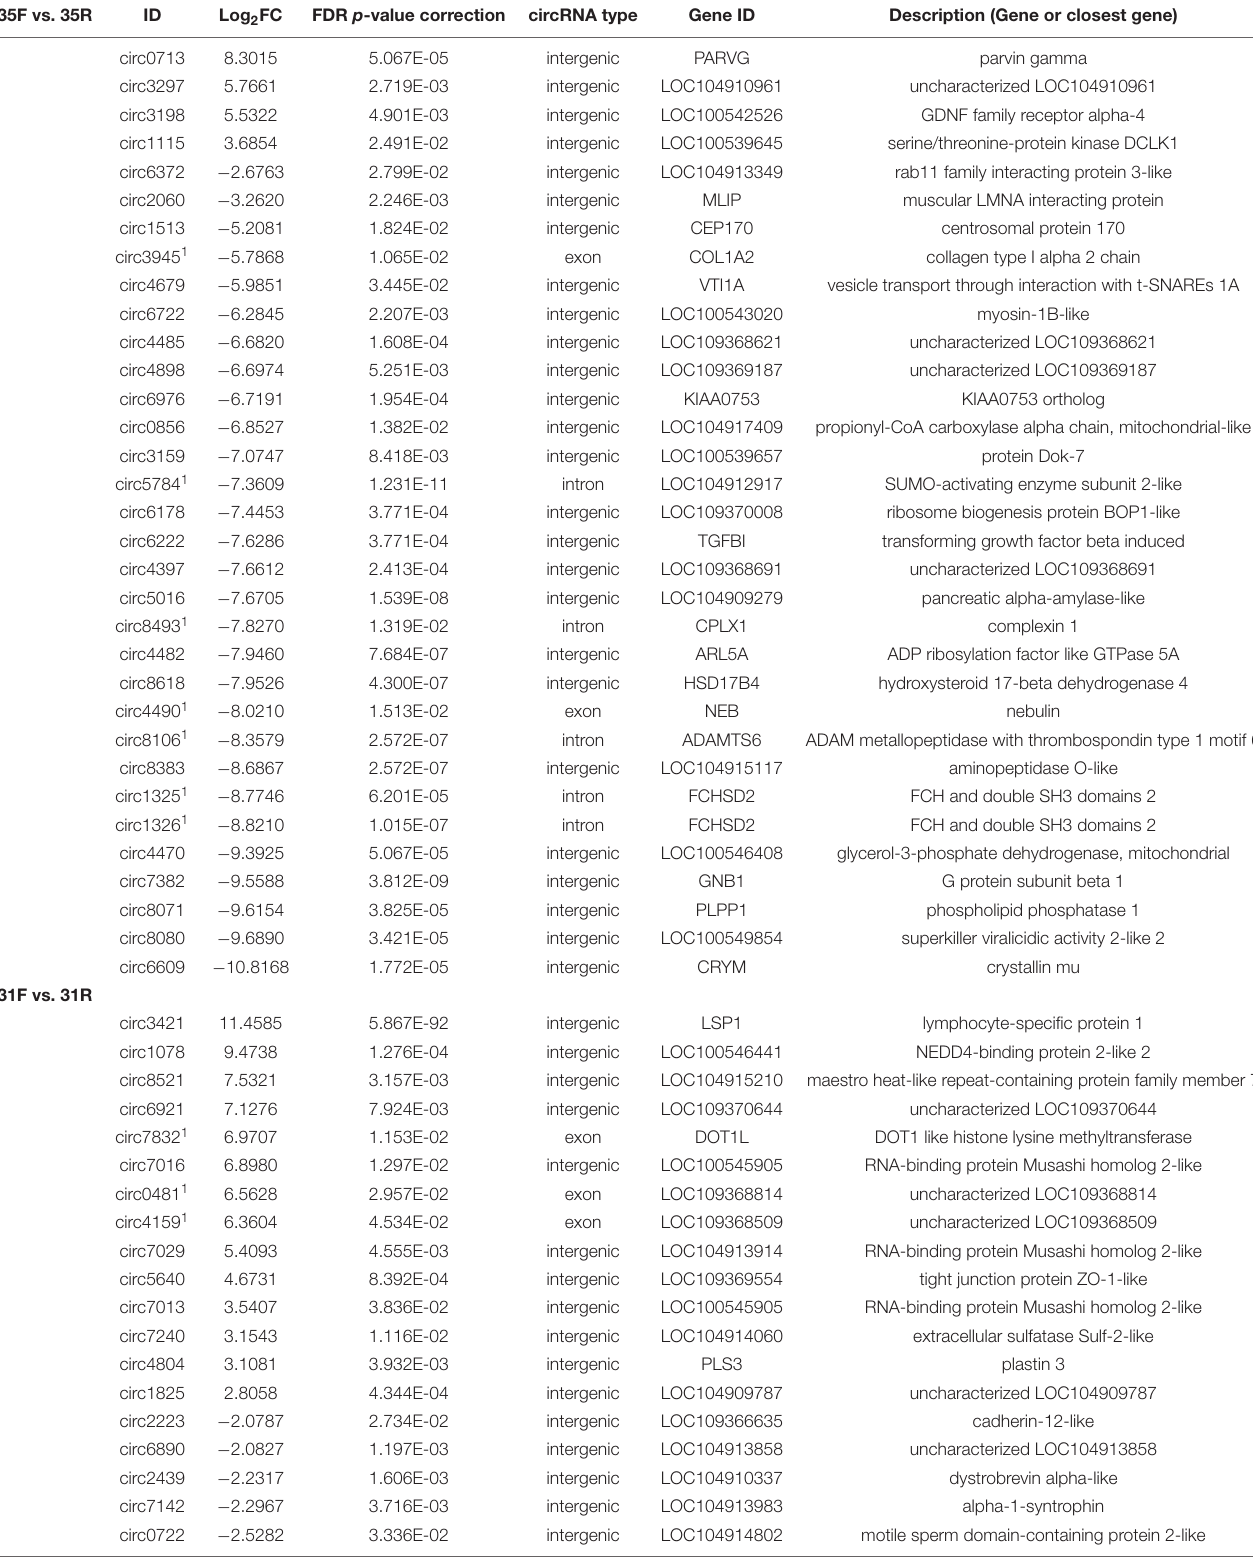
TABLE 4 | Significant differentially expressed circRNAs (FDR P < 0.05 and | Log 2 FC| > 2.0) in within-temperature, between-line comparisons (see Figure 2B ). 35F vs.